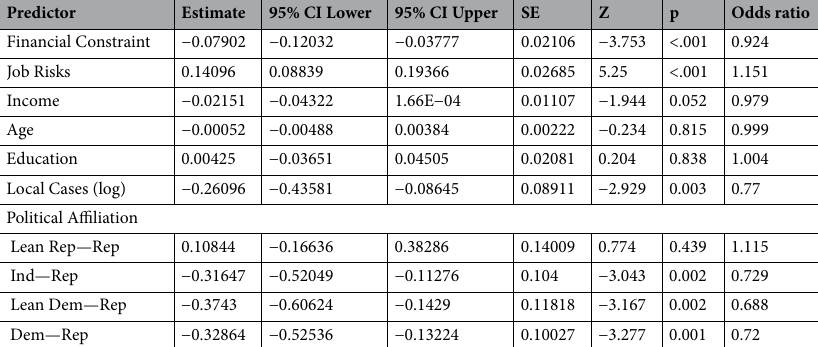
Table 6. Model coefficients for ordinal logistic regression predicting social